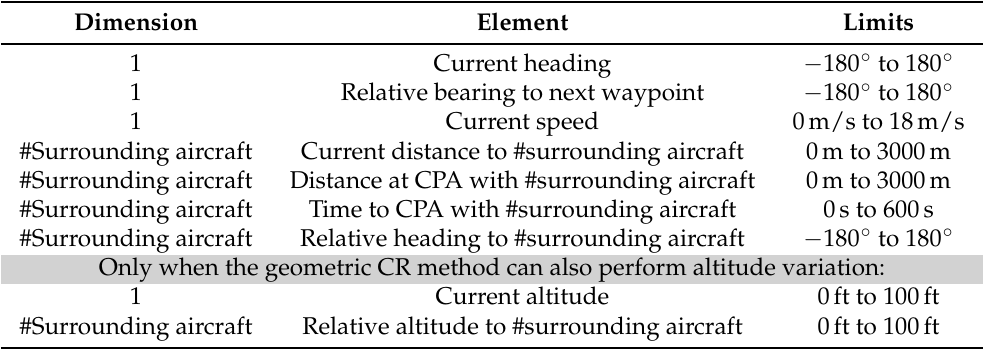
Table 2. State formulation of the RL method.